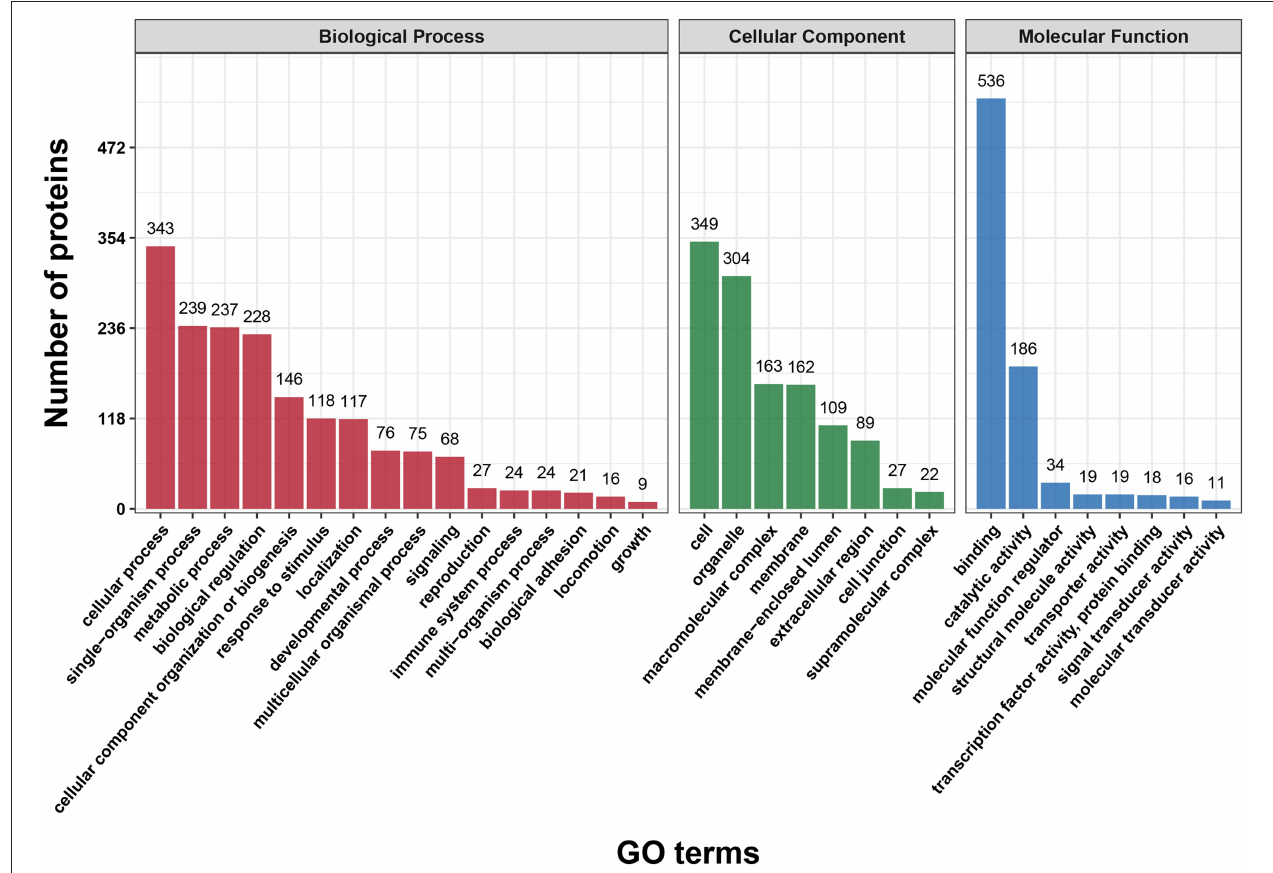
FIGURE 2 | Gene Ontology (GO) classification analysis of differentially expressed proteins (DEPs) in terms of biological process, cellular component and molecular function. Each bar represents the number of DEPs.